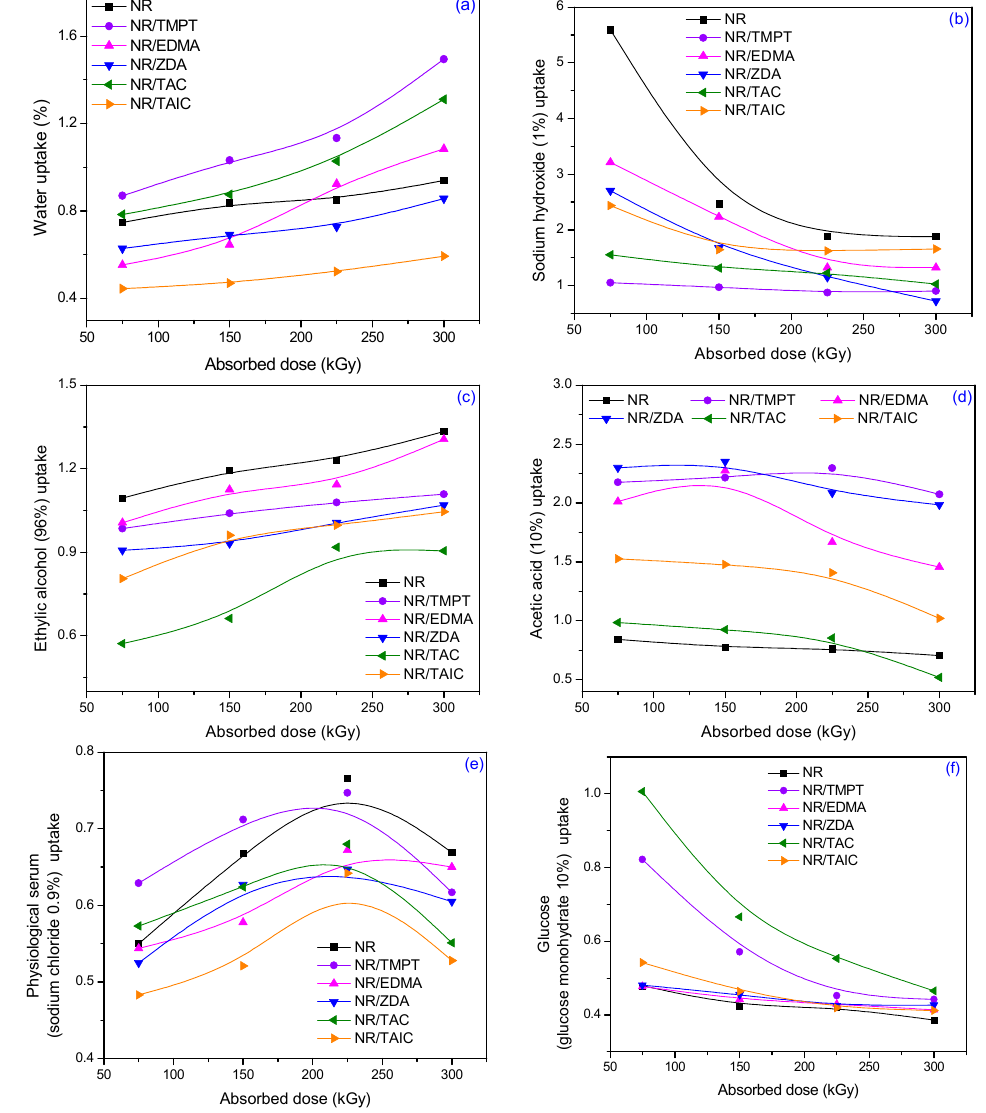
Figure 15. Aqueous solutions uptakes depending on the PFMs type and absorbed dose at 23 ± 2 °C in: ( a ) water; ( b ) sodium hydroxide (1%); ( c ) ethylic alcohol (96%); ( d ) acetic acid (10%); ( e ) physiological serum (sodium chloride 0.9%); and ( f ) glucose (glucose monohydrate 10%).